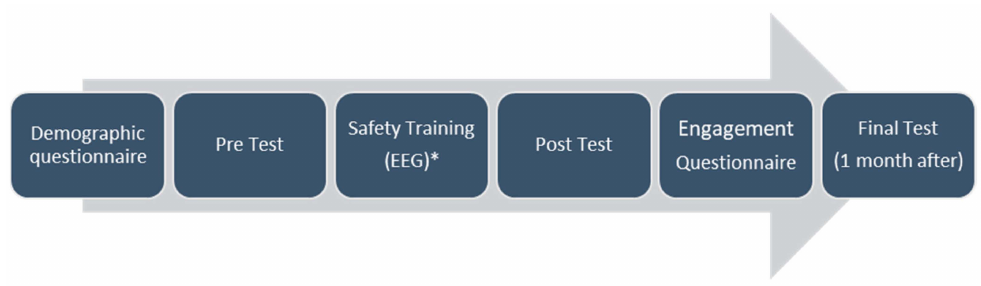
Figure 3. The procedure followed for SBST and VSW training (* 40 participants wore EEG headset while they were going through safety